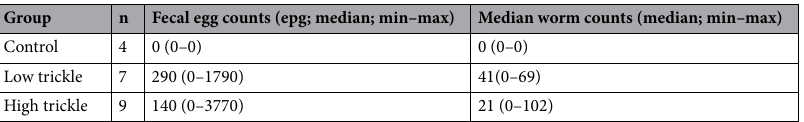
Table 4. Overview of infection status of pigs in the different infection groups. For each of the animals epg counts in stool and macroscopic worm counts in the intestines were determined. epg eggs per gram.